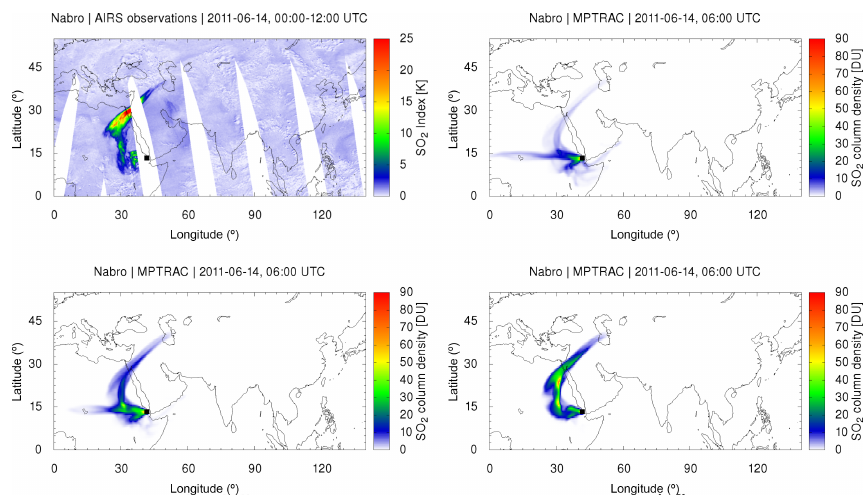
Figure 12. Same as Fig. 11, but for 14 June 2011,